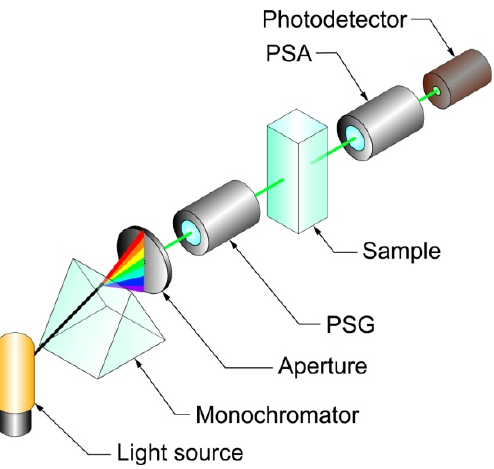
Figure 3. General scheme of a single-beam scanning MM spectropolarimeter.